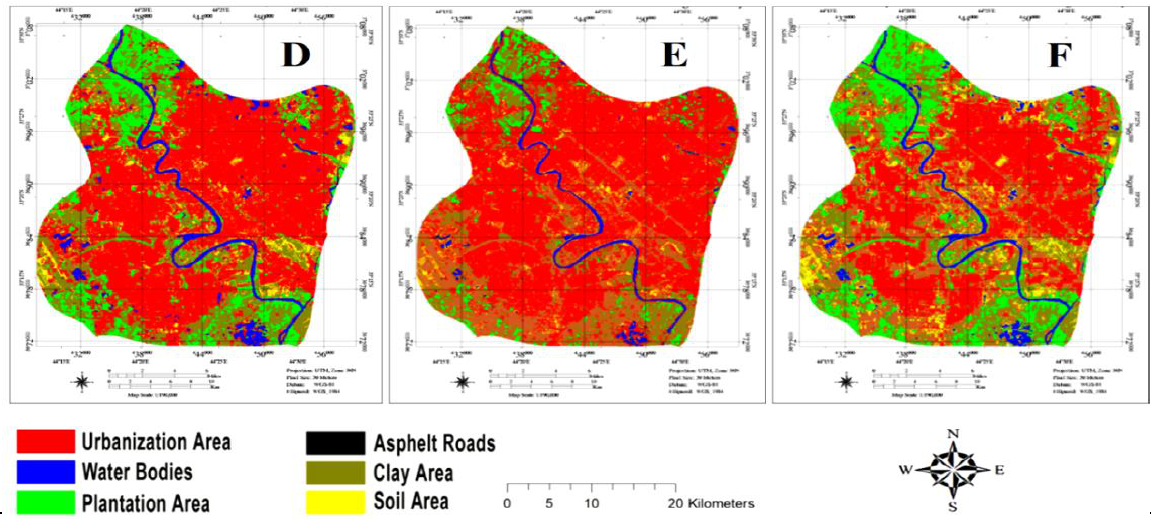
Figure 6. The classified images used the visible images and pan-sharpening images with the combination of the visible and thermal images of 2015; (A) the ANN method on the visible images; (B) the MD method on the visible datasets; (C) the ML method on the visible images; (D) the ANN method on the pan-sharpening with combination datasets; (E) the MD method on the pan-sharpening with combination datasets, and (F) the ML technique on the pan-sharpening with combination datasets.